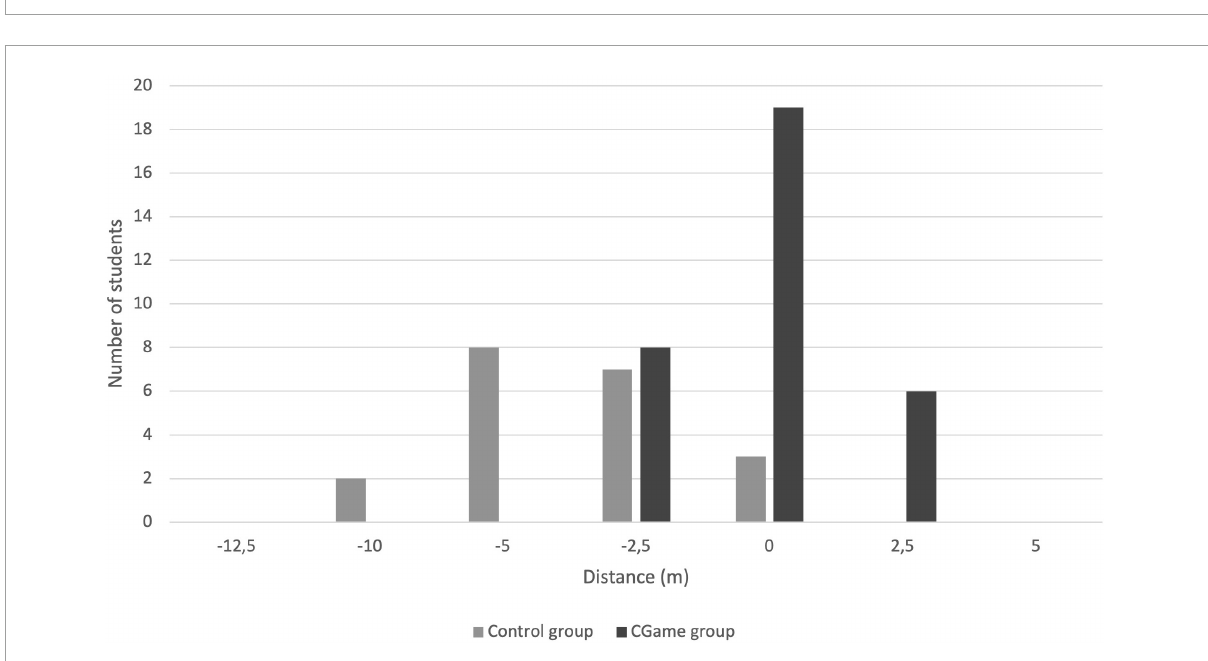
FIGURE2 Difference of distance at post-test apneas between estimation and the real distance performed for both groups. The homogeneity test shows that the groups are to be considered significantly different (Chi 2 = 21.99, dof = 1, r < 0.001). We notice that 19 of the 33-CGame group swimmers achieved a perfect match between saying and doing (concordance). The remaining 14 CGame participants only deviated by a maximum of 2.5 m from the estimation. For the first time, there was overestimating (for six swimmers of the CGame